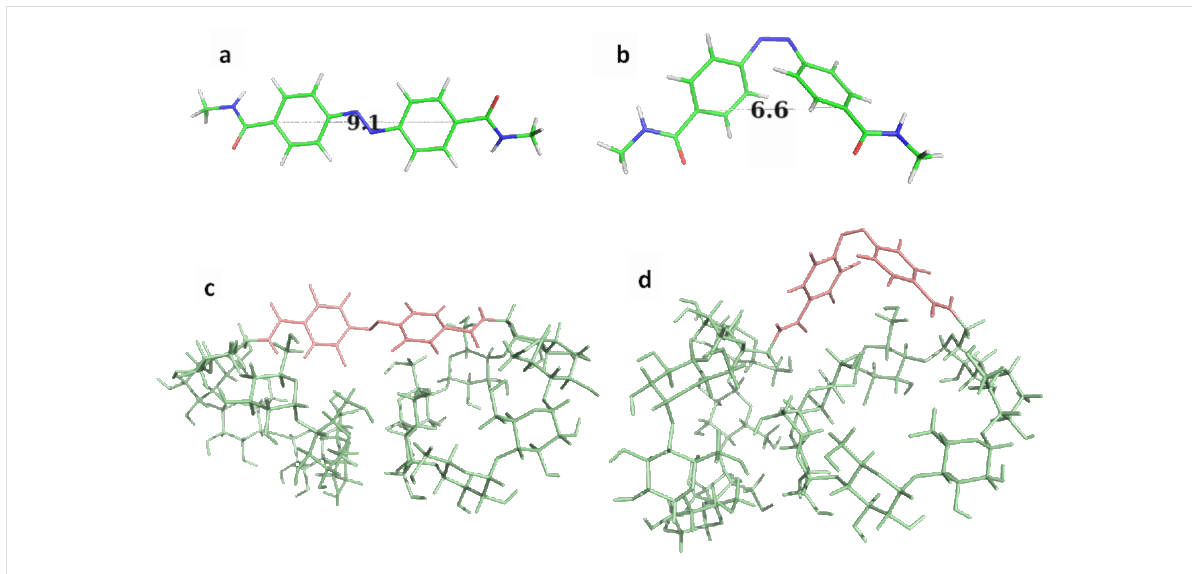
Figure 4: Representation of the most stable structures obtained for the azobenzene linker (a) for the trans configuration and (b) for the cis one and for the AZO-CDim 1 systems (c) for the trans configuration and (d) for the cis one.